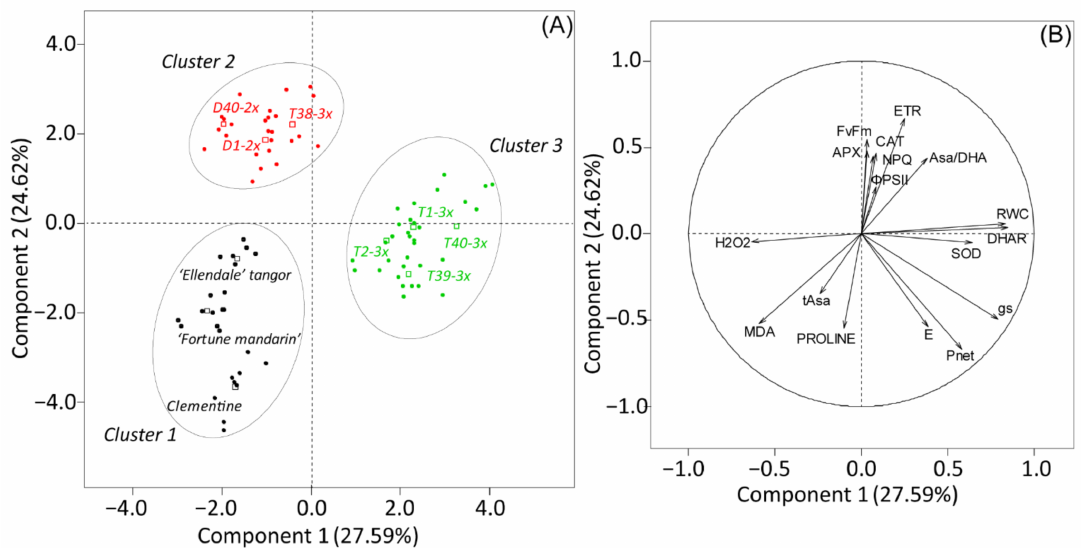
Figure 6. Principal component analysis (PCA) performed on leaves of 2x and 3x genotypes after the recovery period. ( A ) Clustering of genotypes on the two first components and ( B ) contribution of each physiological and biochemical parameter to the two first components of